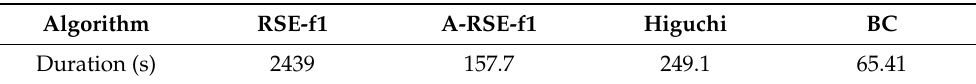
Table 1. The calculation durations of RSE-f1, A-RSE-f1, Higuchi, and BC algorithms to process all 40 sets of vibration signals.